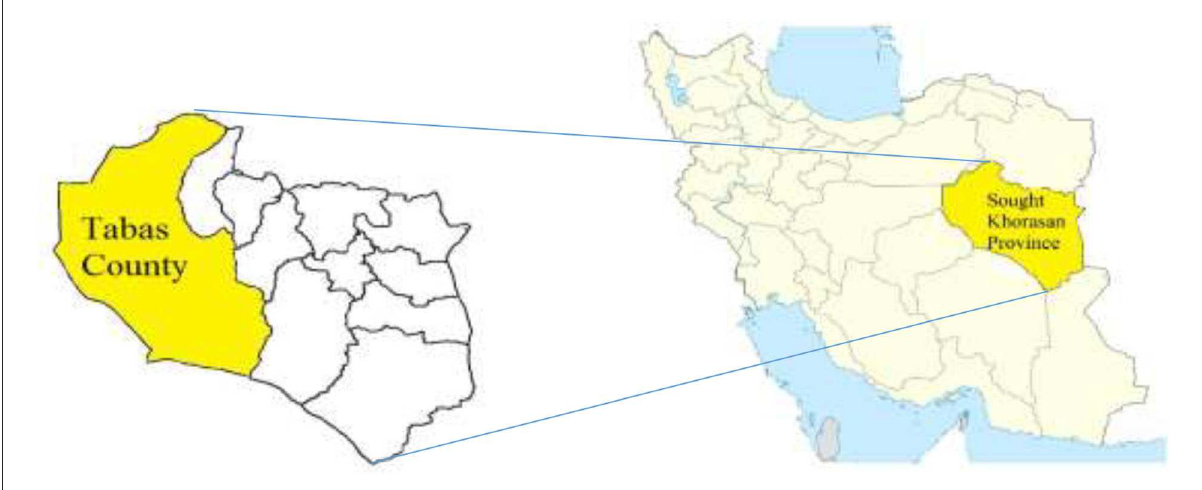
FIGURE1 Geographic position of the study